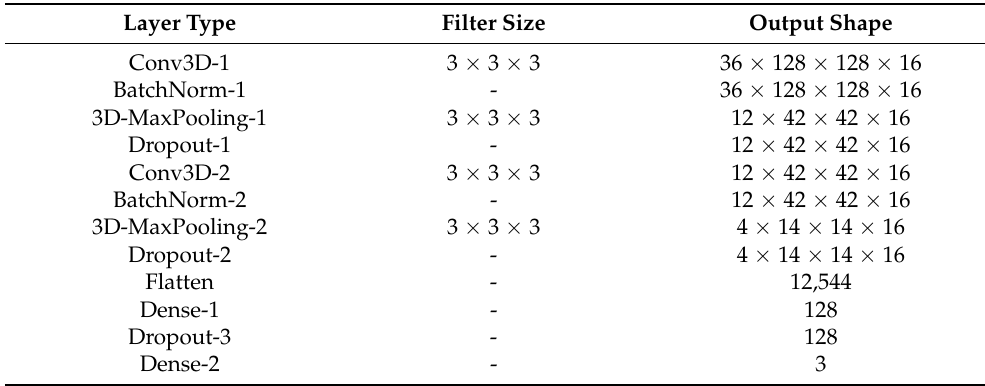
Table 2. Summary of our Model-A with CASME II dataset samples as